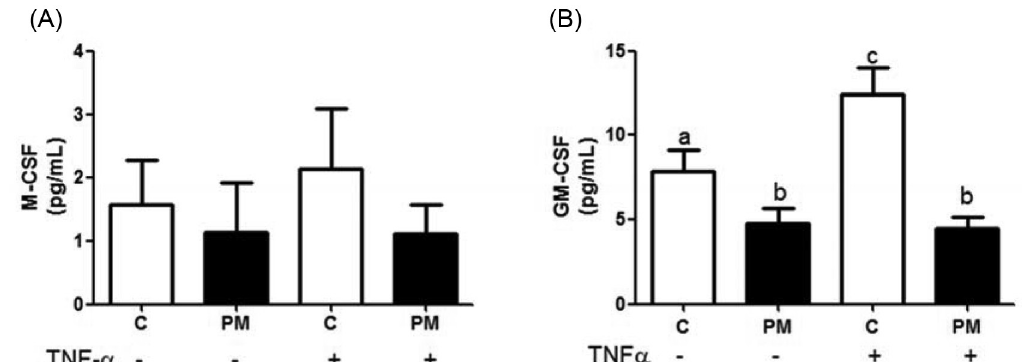
FIGURE 2 - Results are expressed as the mean and standard deviation of the levels of M-CSF ( A ) and GM-CSF ( B ) in the supernatant of a 2 h peritoneal cell culture stimulated or not stimulated with 10 ng/mL TNF- α and from the control (C) (n = 6) or protein-malnourished (PM) (n = 6) groups. Different superscript letters indicate significant differences among the groups (p ≤